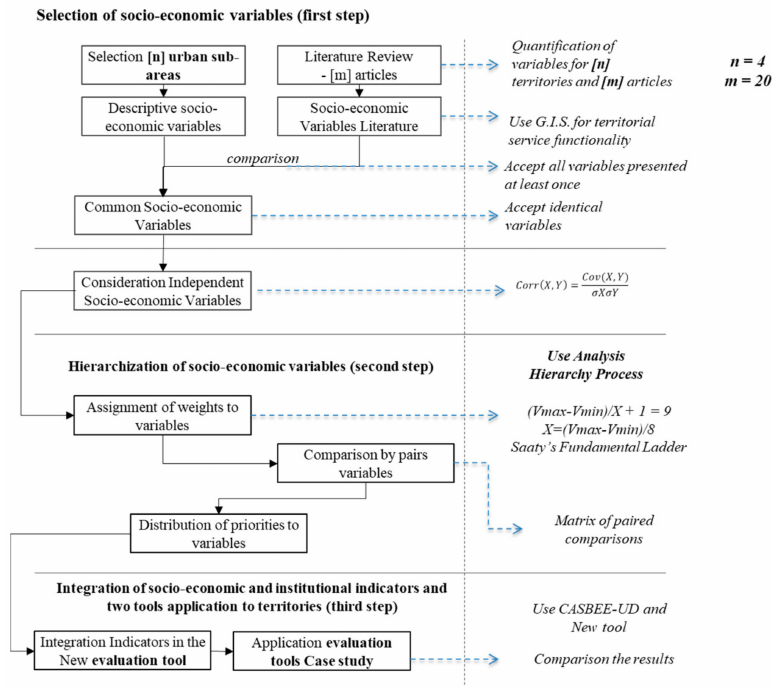
Figure 1. Methodological